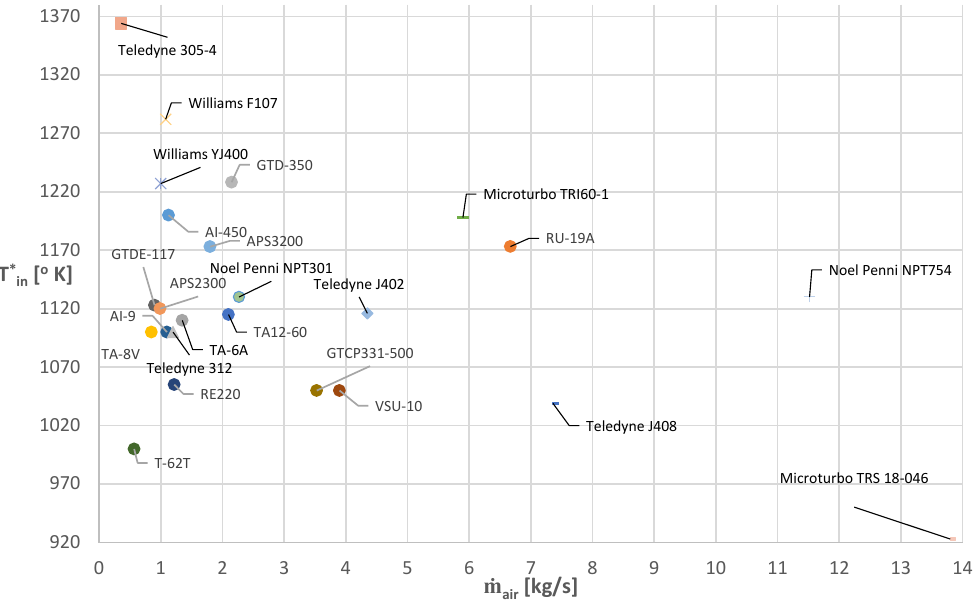
Figure 14. Comparison of the TIT (T *in ) and ṁ air of small turbojet and turboshaft engines.